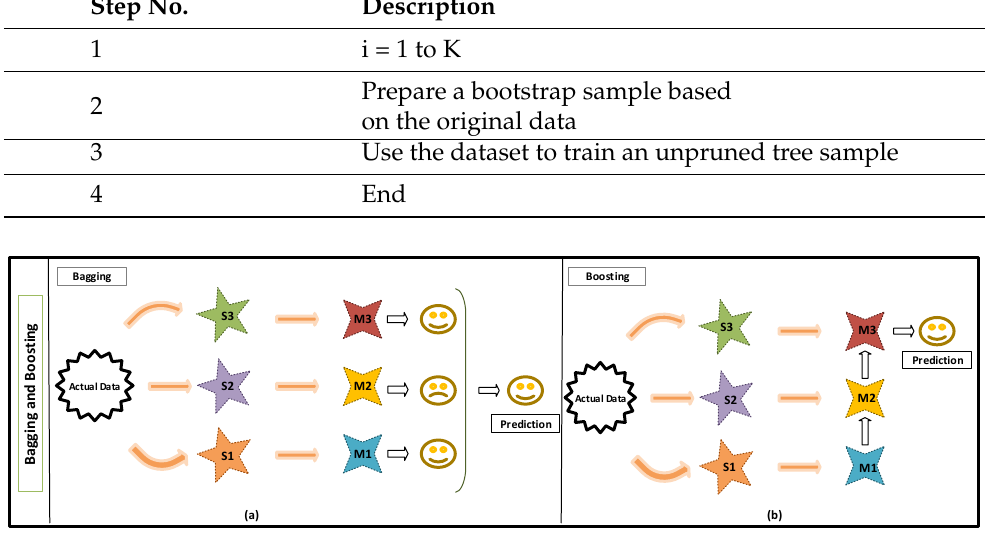
Figure 3. Pictorial representation of algorithms based on the evolution of determination trees from basic decision algorithms to gradient boosting ( a , b ).